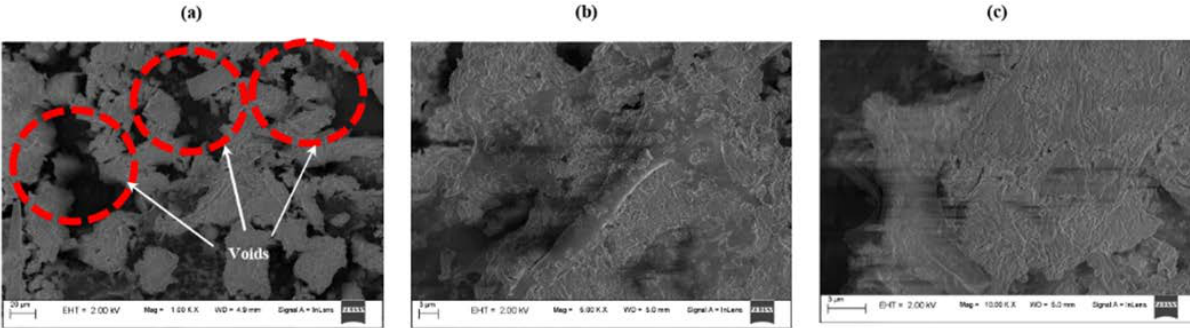
Figure 4. Sample SEM micrographs of Agartala peat at magnification (a) ×1,000, (b) ×5,000 and (c)